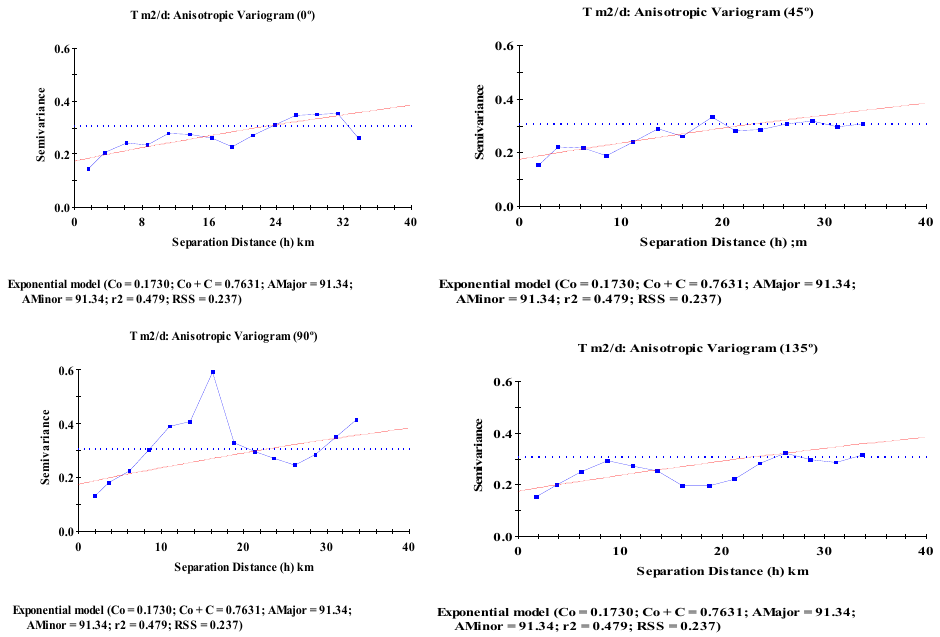
Figure 7. Directional variograms of the log(T) of the Kg aquifer.